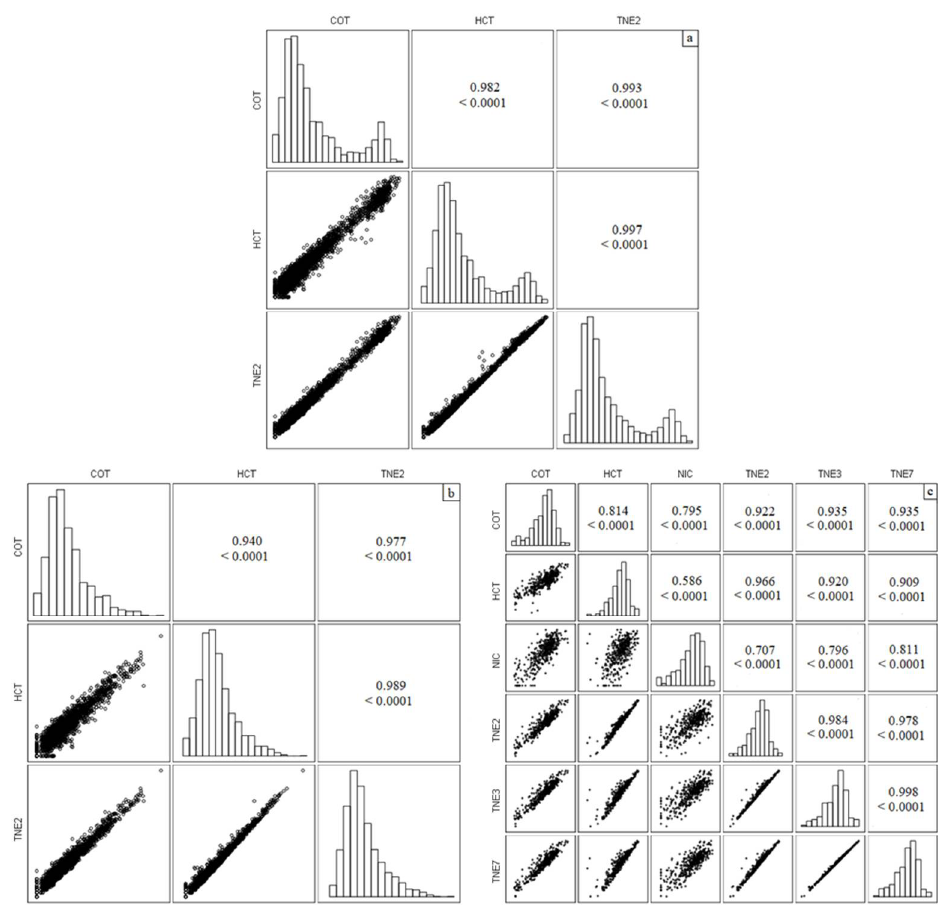
Figure 1. Logarithmic distributions and correlations for urinary cotinine, trans-3′-hydroxycotinine, nicotine, and TNEs, from NHANES 2015–2016. Within each panel, the Pearson correlation coefficient is designated as the top number, and the p -value is designated as the bottom number. Pearson correlation coefficients are obtained from un-weighted, log-transformed (base 10) biomarker and TNE concentrations without adjusting for the urinary creatinine concentration. Each panel contains information for ( a ) combined non-user and user populations, ( b ) non-user population only, and ( c ) user population only.